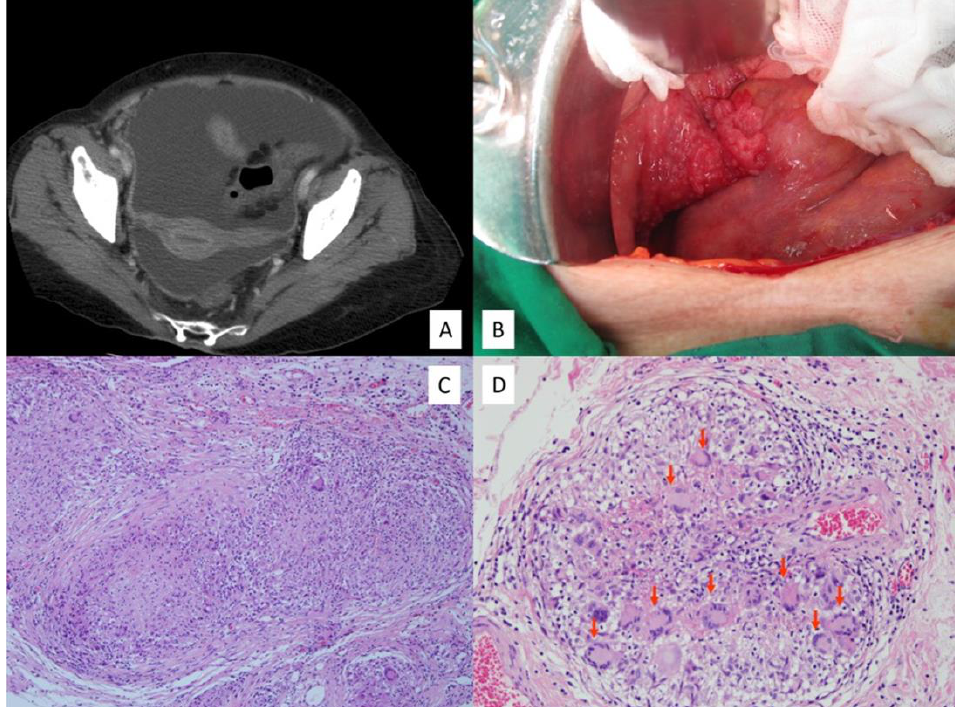
Figure 1. ( A ) Pelvic computed tomography of peritoneal tuberculosis showed massive ascites with thickened peritoneum. ( B ) Intra-operative findings show multiple miliary nodules over the fallopian tube, bowel serosa, and parietal peritoneum. ( C ) Histology from peritoneal tuberculosis showed granulomas with caseous necrosis and ( D ) multinuclear giant cells (red arrows) in the granuloma (Hematoxylin and Eosin stain).